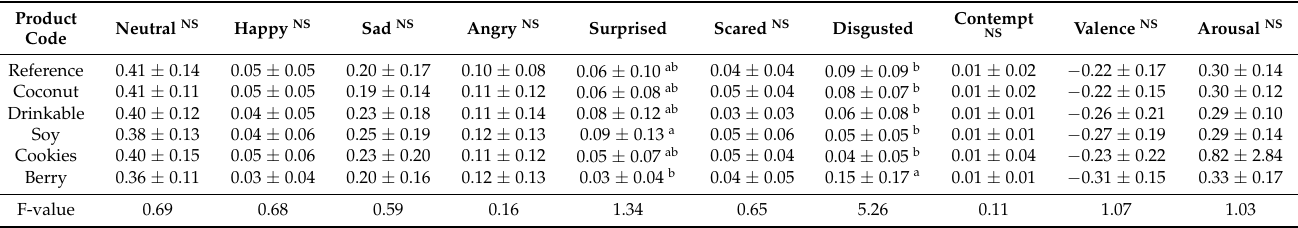
a,b Means with different superscripts in each column indicate significant differences ( p < 0.05) by the Fisher’s least square difference test. NS indicates no significant differences in that column ( p > 0.05). Highest value indicated with ‘a’ in superscript. The data are presented as mean ± standard